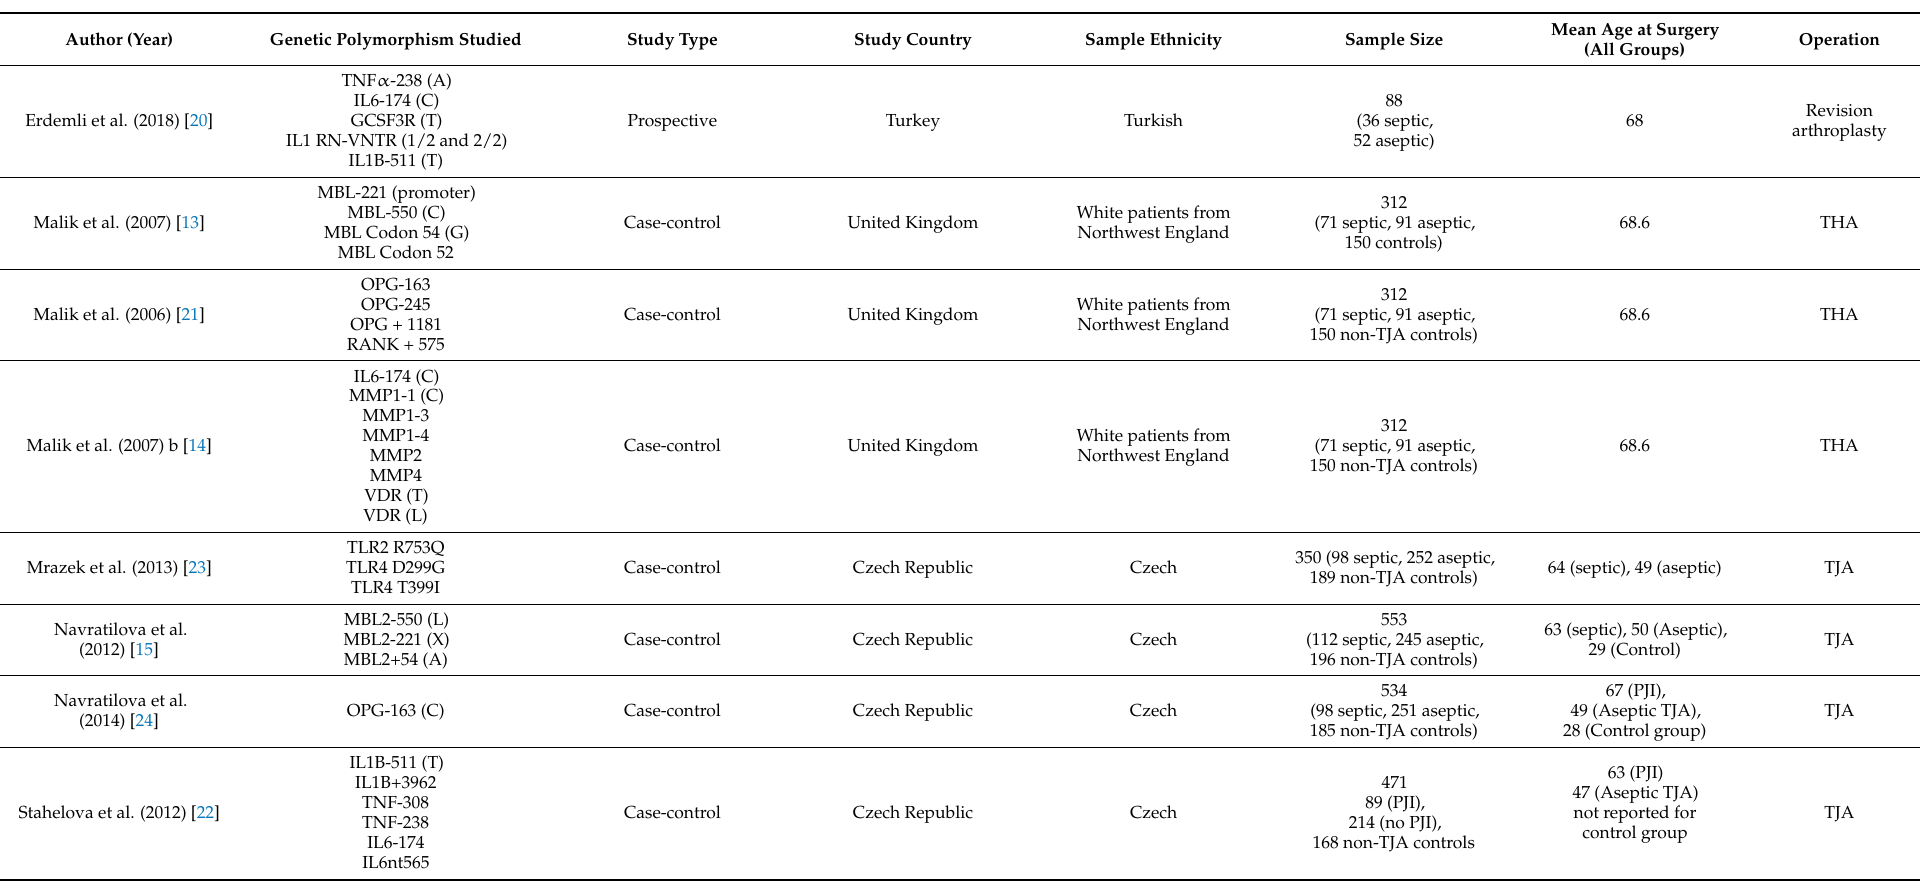
Table 1. Characteristics of included